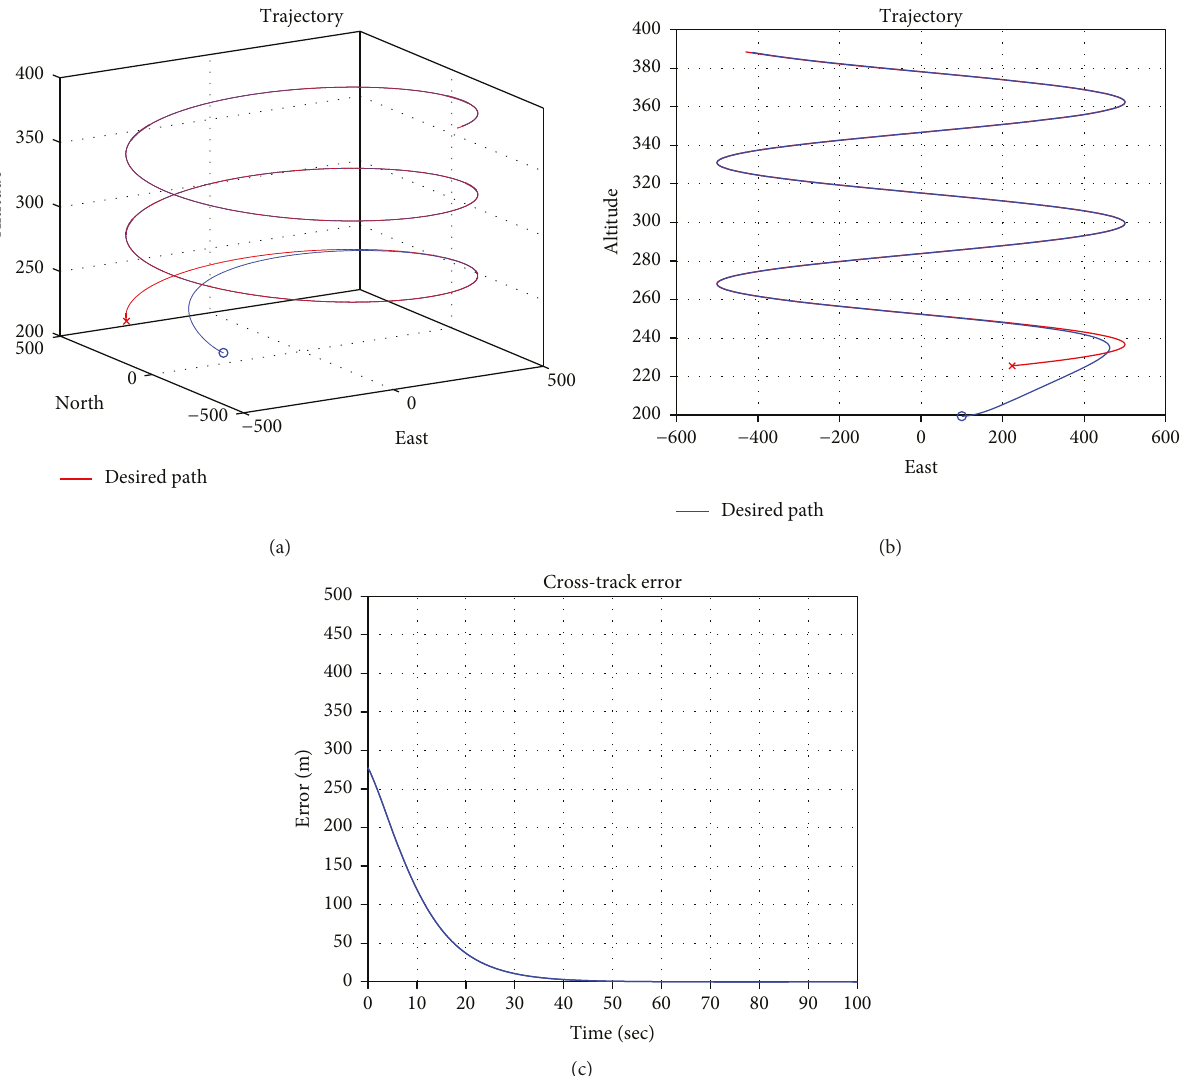
Figure 16: Helical path following. (a) Three-dimensional view, (b) side view, (c) cross-track